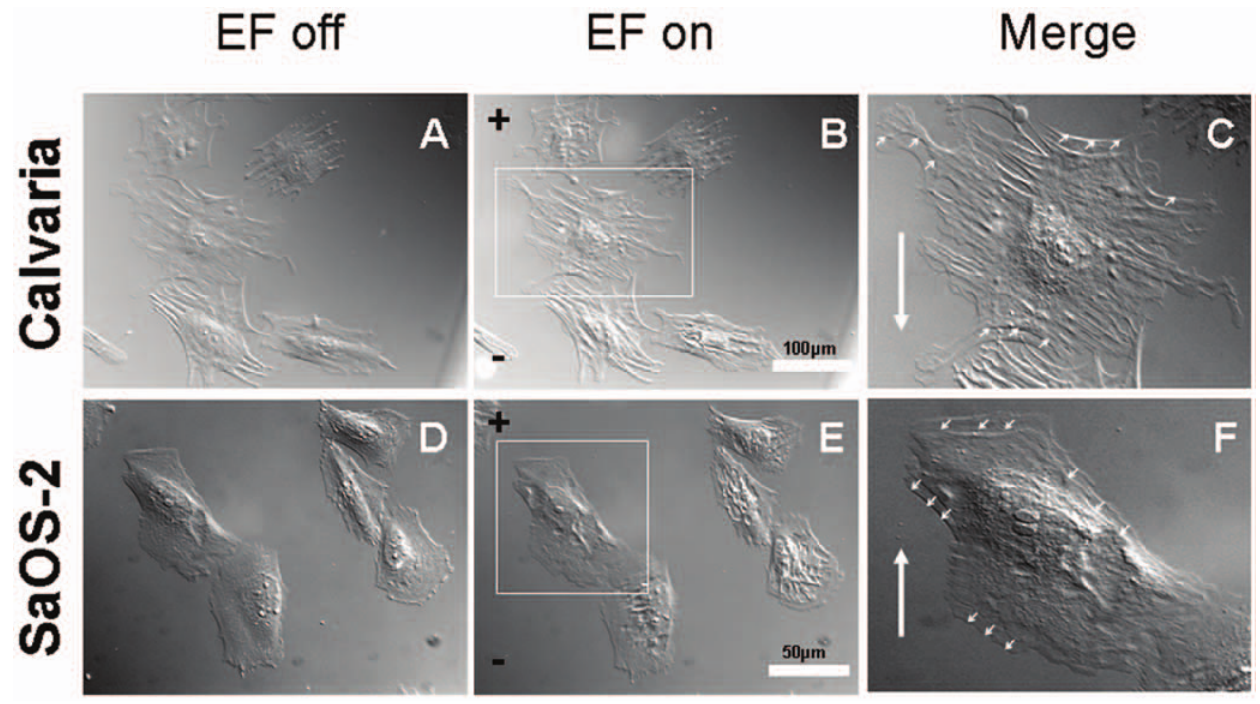
Figure 6. DIC time-lapse frames showing opposing contraction forces induced by dcEFs. (A,D) Calvaria osteoblasts and SaOS-2 cells before dcEF exposure. (B,E) Calvaria and SaOS-2 cells with contracted cell bodies 1 min after switching the dcEF (10 V/cm applied here) on. (C,F) Merged images of a single calvaria and SaOS-2 cell, marked with a white rectangle in B and in E, representing contraction and positional shift (small white arrows on the cell periphery) towards anode and cathode, respectively. Big white arrow in C and in F indicates the direction of calvaria and SaOS-2 cell migration towards cathode and anode, respectively. n cell =17–21.